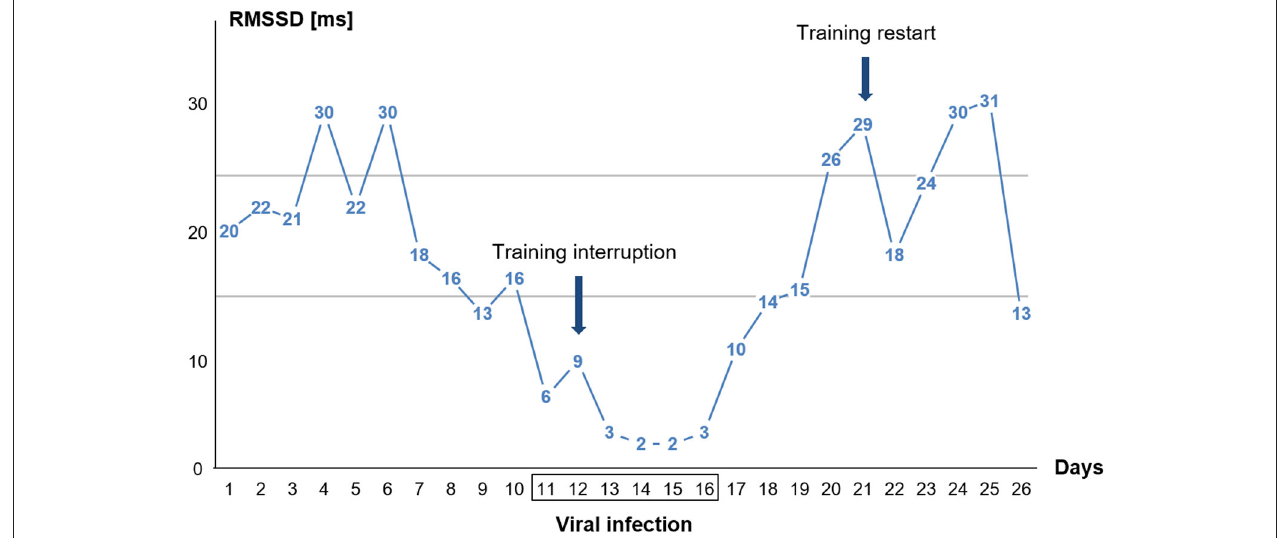
FIGURE 2 | Single day values for time-domain heart rate variability (HRV) parameter RMSSD in the standing position of the orthostatic test (OT) before, during, and after the viral infection. The athlete had fever on days 13, 14, and 15. The two horizontal lines indicate the area of the individual smallest worthwhile change (SWC) in standing RMSSD during baseline (see section